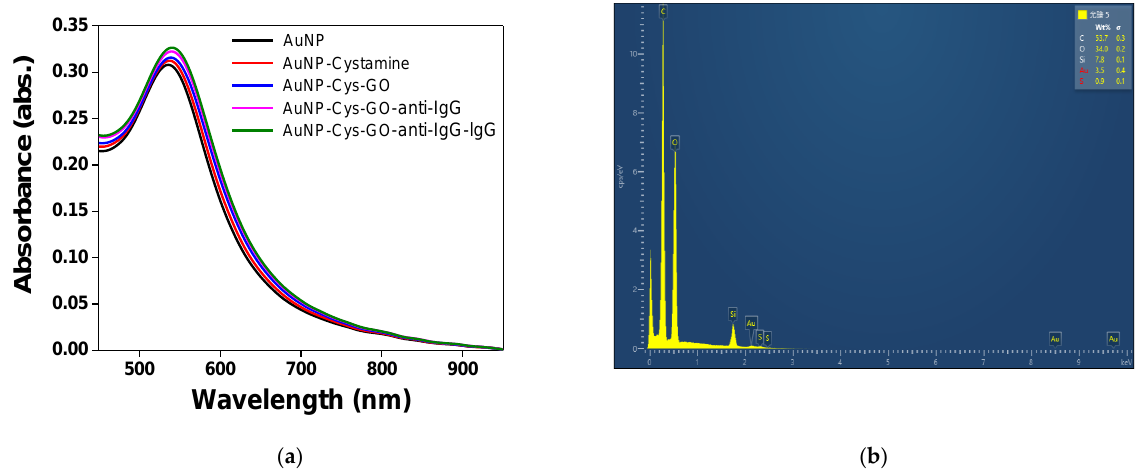
Figure 4. ( a ) Gradual functionalization of AuNP, AuNP – cystamine, AuNP – Cys – GO, AuNP – Cys – GO – anti-IgG and AuNP – Cys – GO – anti-IgG – IgG in the probe modification spectrogram; (b ) EDS measurement verification.